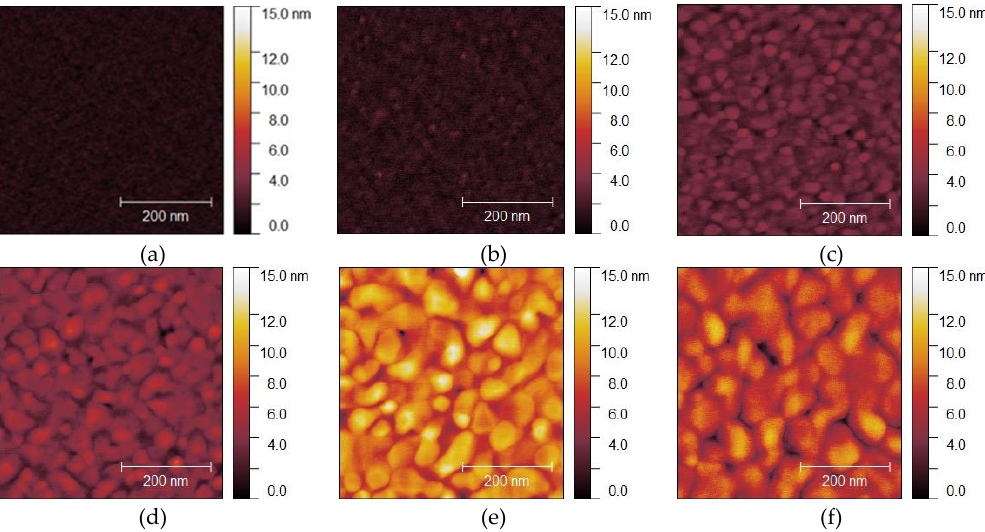
Figure 2. Typical atomic force microscope (AFM) images of Au thin films deposited on Si wafers: ( a ) before deposition; ( b )–( f ) deposited films with thicknesses of 15, 50, 100, 300, and 500 nm, respectively.